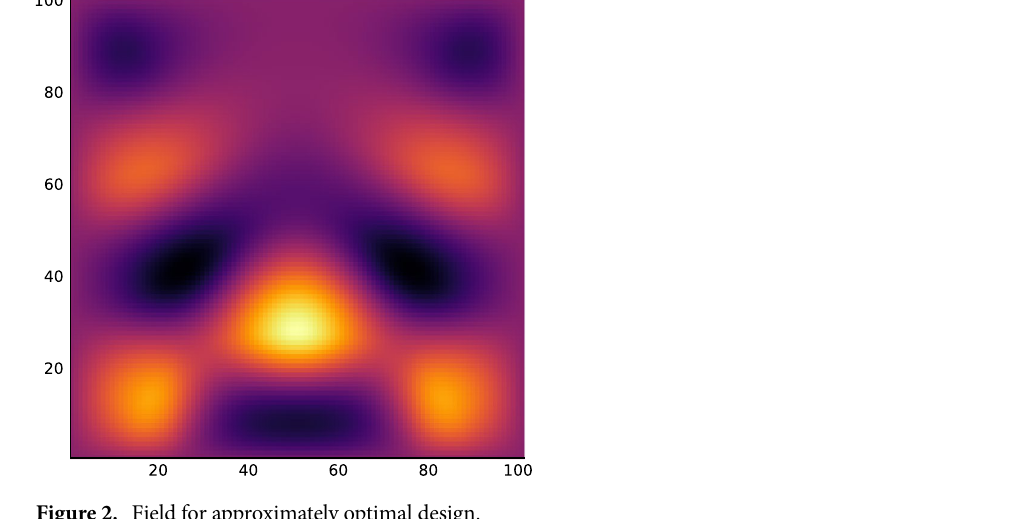
Figure 2. Field for approximately optimal